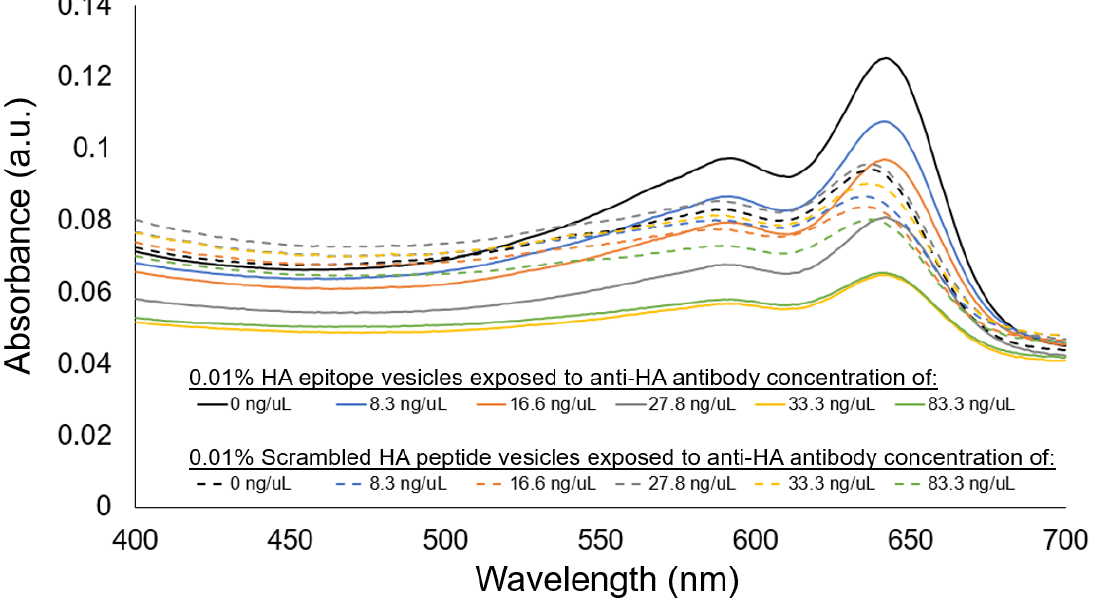
Figure 8. Visible spectra showing anti-HA antibody concentration-dependent aggregation response of 0.01% HA epitope-displaying vesicles (solid lines), with no concentration-dependent response observed for 0.01% scrambled HA peptide vesicles (dashed lines).